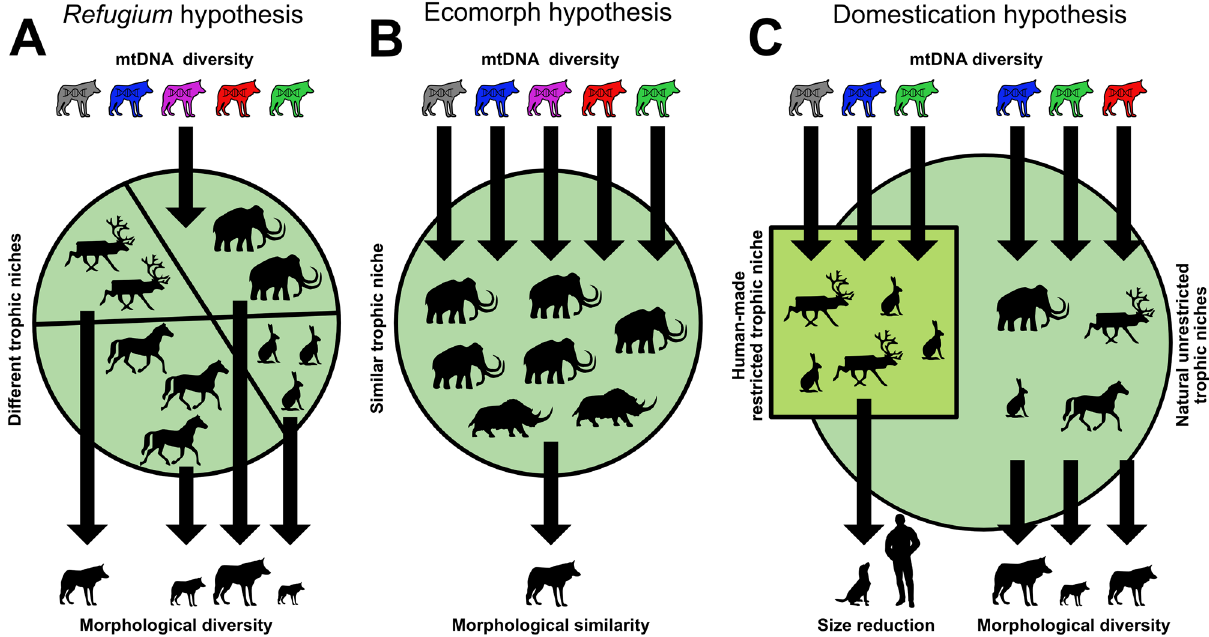
Figure 5. Graphic presentation of the three hypotheses of the adaptation to environmental changes; (A) refugium hypothesis, (B) ecomorph hypothesis, (C) domestication